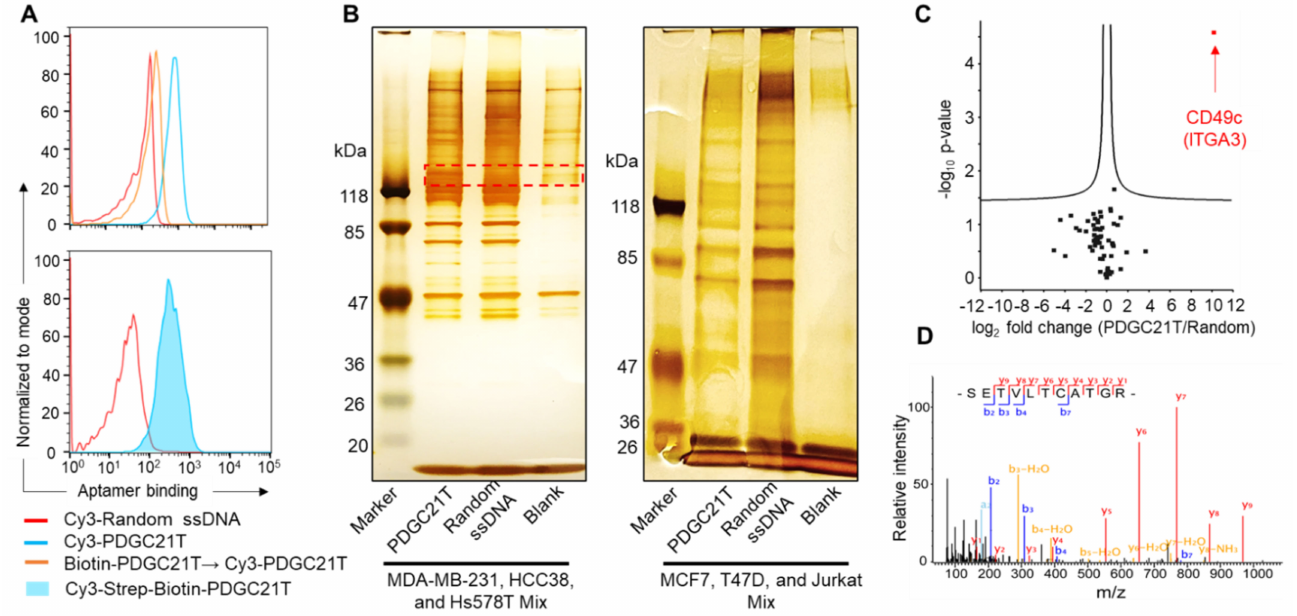
Figure 4. Identification of the PDGC21T aptamer target molecule. ( A ) Biotinylated PDGC21T aptamer targeted MDA-MB-231 cells with a similar binding capacity to that of Cy3-labeled PGC21T aptamers. In contrast, random ssDNA controls did not bind MDA-MB-231 cells. Biotin-PDGC21T → Cy3- PDGC21T indicates MDA-MB-231 cells that were first incubated with biotinylated PDGC21T and then incubated with Cy3-labeled PDGC21T. The final incubation concentration of aptamers or random ssDNA was 200 nM. ( B ) Aptamer-mediated immunoprecipitation assays. Membrane proteins derived from TNBC cells (MDA-MB-231, HCC38, and Hs578T mixtures) and non-TNBC cells (MCF7, T47D, and Jurkat mixture) were prepared and used for co-precipitation with biotinylated PDGC21T aptamer, biotinylated random ssDNA, or vehicle alone as a blank control. Resultant aptamer and target complexes were pulled down by streptavidin-immobilized agarose beads and separated on sodium dodecyl sulphate-polyacrylamide gel electrophoresis (SDS-PAGE), followed by silver staining. The red-dotted box shows the protein band of interest, which was collected for liquid chromatography tandem mass spectrometry (LC-MS/MS) identity analysis. The uncropped figures are shown in Figure S4. ( C , D ) LC-MS/MS identification of the target of PDGC21T. The proteins detected in PDGC21T aptamer and random sequence pull-down experiments were identified and quantified with label-free LC-MS. ( C ) Volcano plot of identified proteins. Each dot represents one protein. Proteins above the cutoff curves are statistically significant (Student’s t -test with 1% permutation-based FDR below 0.01). ( D ) Annotated MS/MS spectra of CD49c (ITGA3) peptide, STEVLTCATGR. The protein band was collected for label-free LC-MS/MS analysis. A total of 64 pro- teins with <1% false-positive rate (FDR) were detected and quantified (Tables S1 and S2). Student’s t -test with permutation-based FDR correction was used to identify proteins whose abundance varied significantly between the two samples (PDGC21T aptamer vs. random ssDNA). Integrin α 3 (CD49c, encoded by ITGA3 ) was the only protein significantly